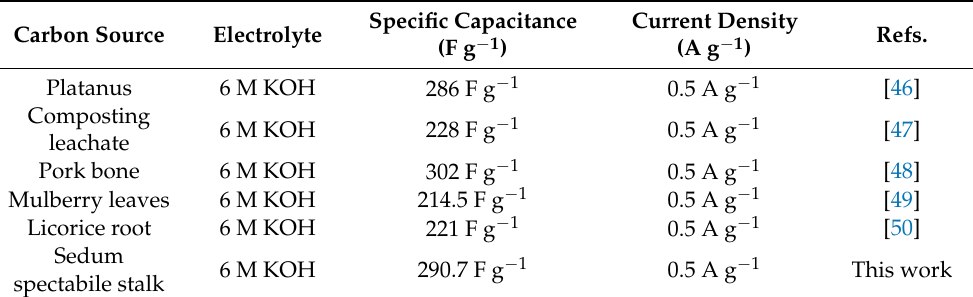
Table 2. Comparison of specific capacitance of B/S-SCs-1 with the reported biomass-derived carbon materials in references.